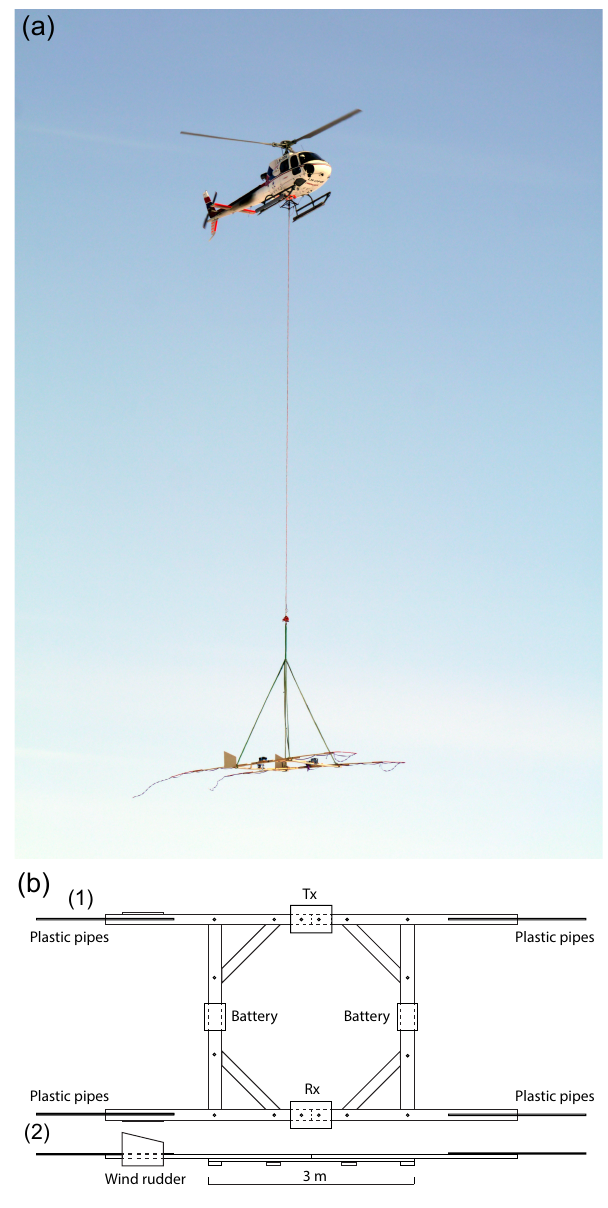
Figure 2. (a) Helicopter with radar frame. Photo: Nick Hulton. (b) Helicopter wooden frame (1) from above, with transmitter (Tx), receiver (Rx), two batteries and four plastic pipes for holding the an- tennas, and (2) from the side, with two fins on one side that function as wind rudders to prevent the frame from spinning. The antennas are connected to the Tx and Rx and fixed to the frame extending out on the plastic